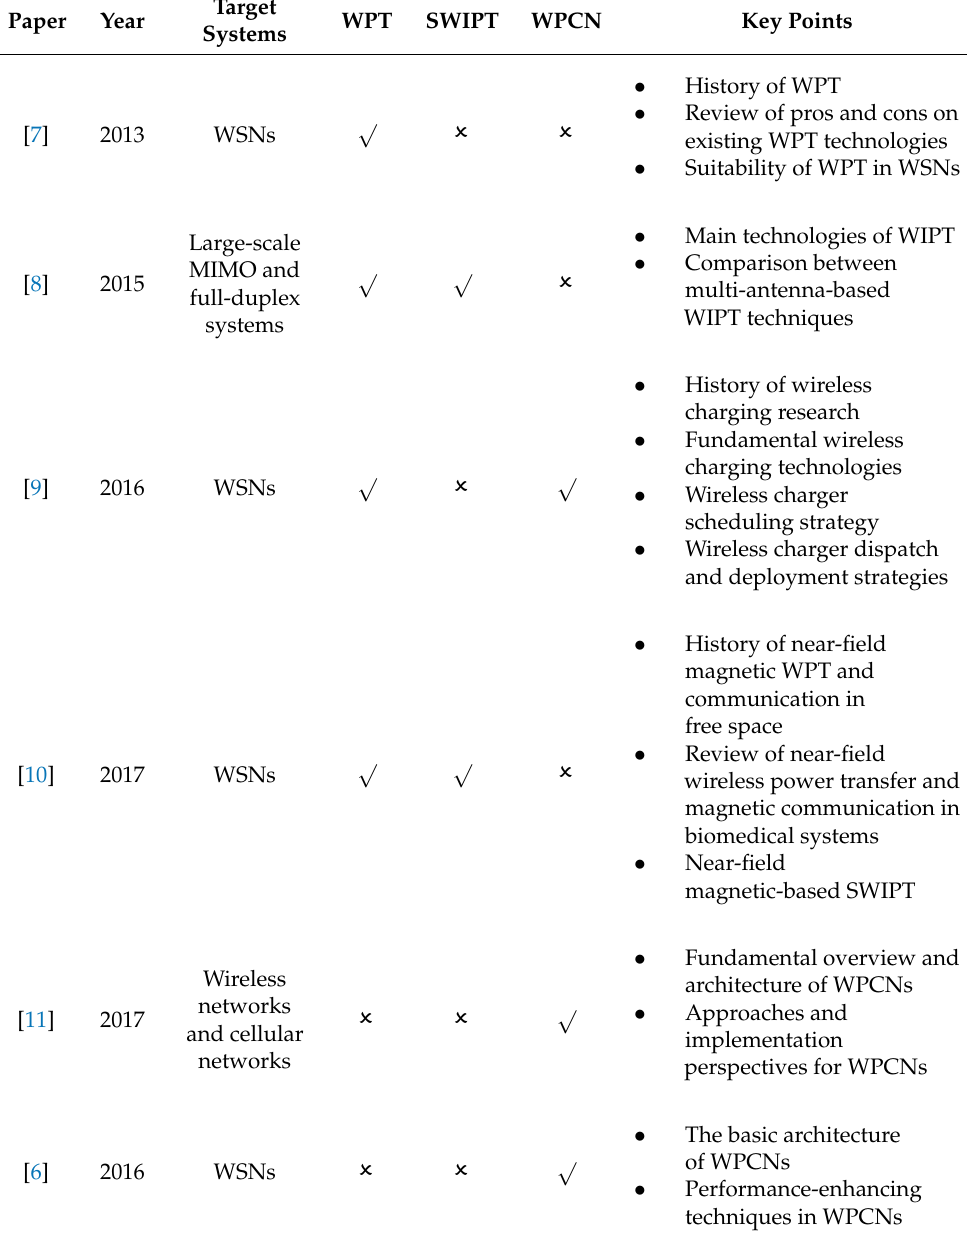
Table 1. Comparison of the existing surveys related to our study.